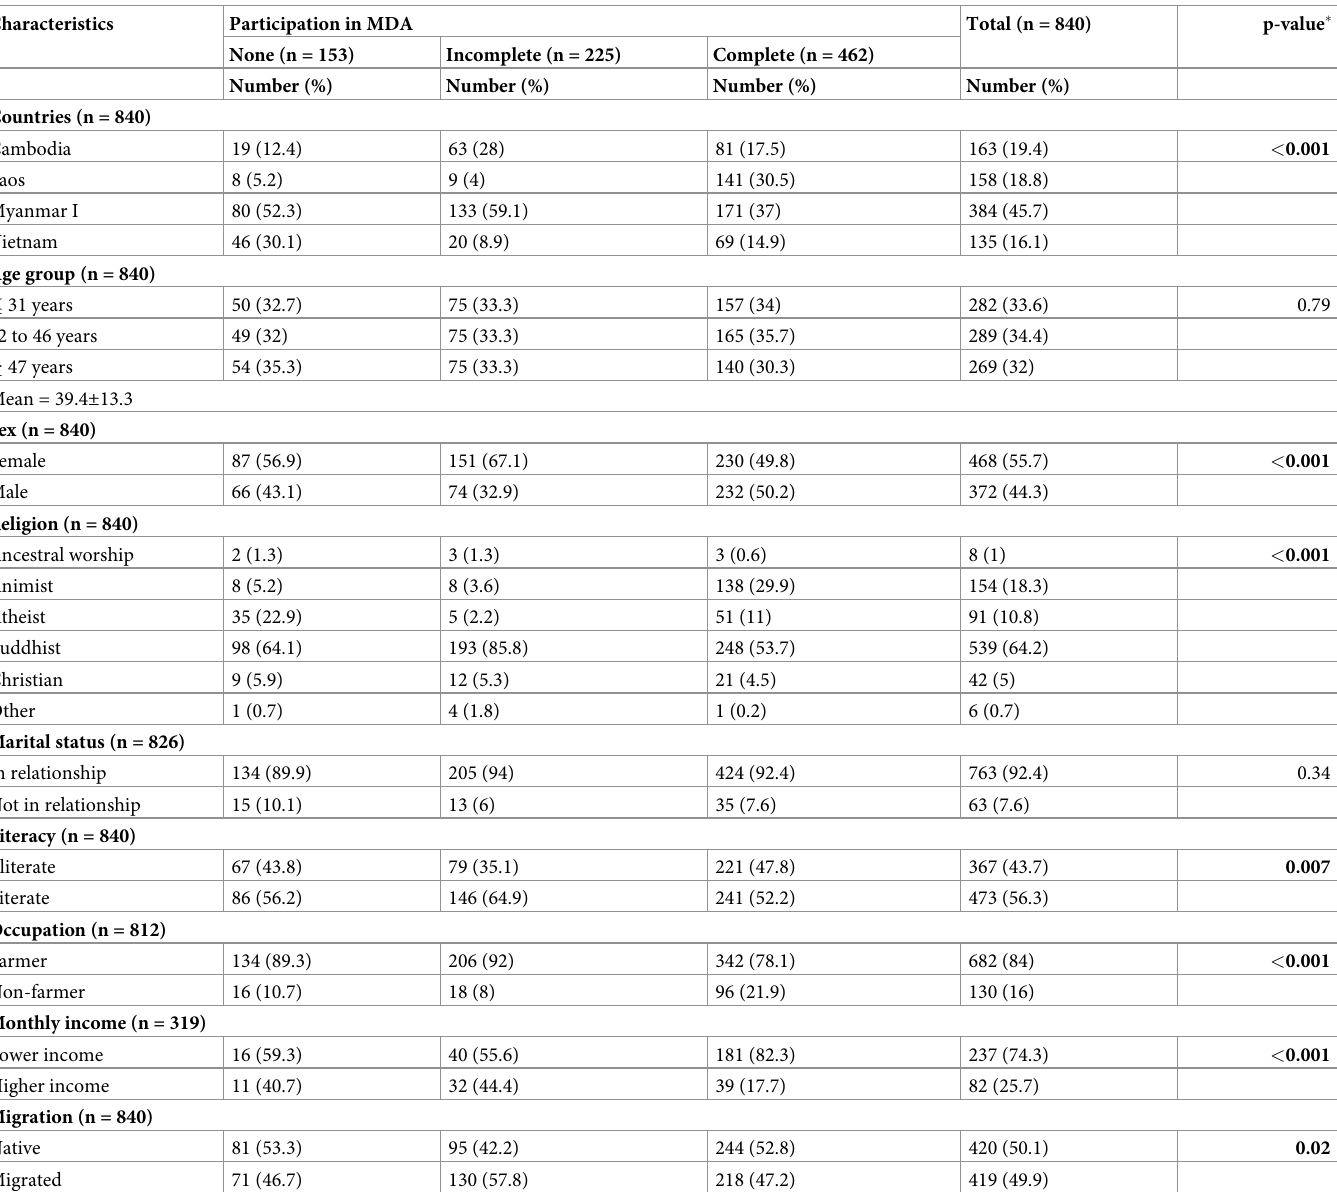
Table 4. Socio-demographic characteristics of survey respondents in relation to MDA (n = 840).